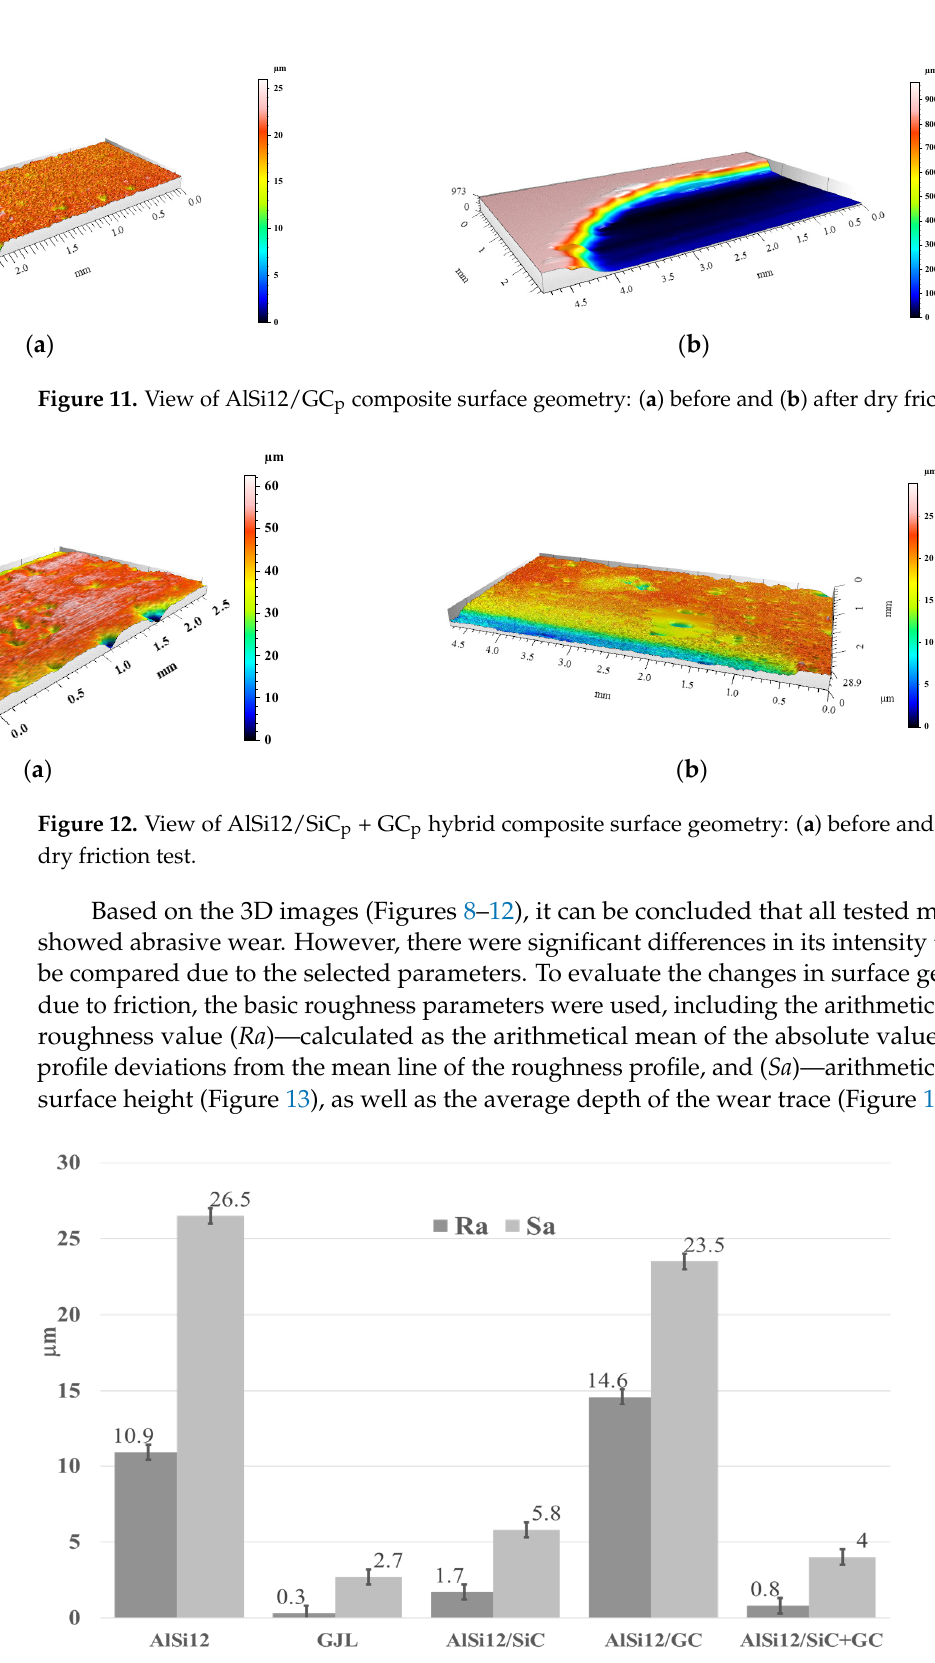
Figure 13. Roughness parameters value ( Ra ) and ( Sa ) of the wear track for all tested materials.